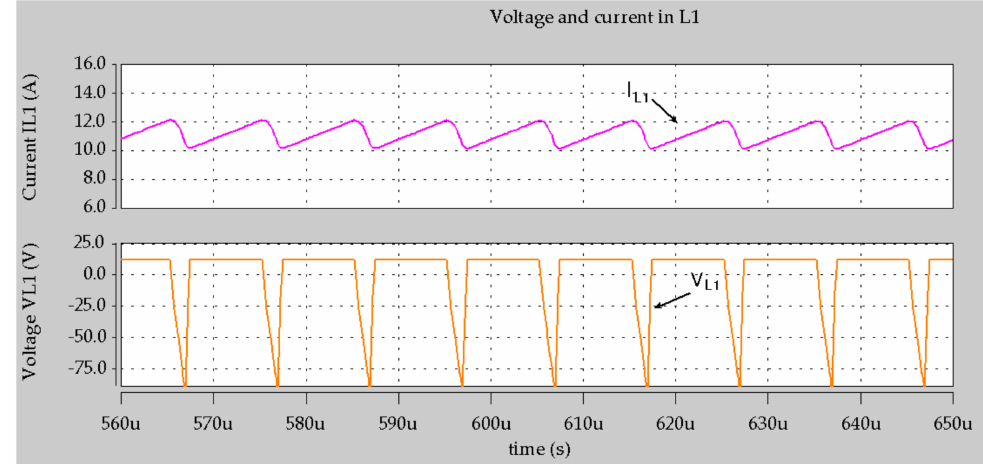
Figure 5. Simulation results for I L 1 and V L 1 .